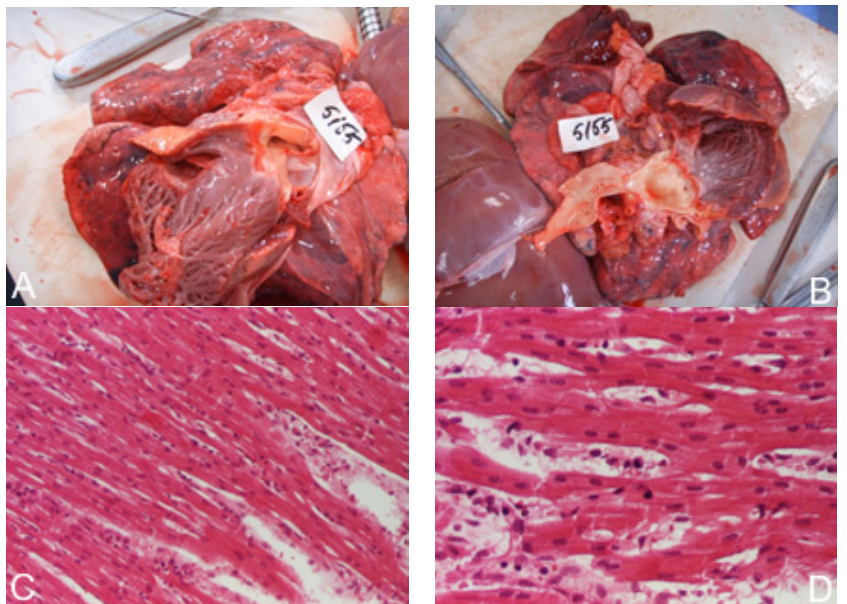
Figure 3. Dilated cardiomyopathy echocardiogram. ( A )—Severe mitral regurgitation (apical four- chamber); ( B )—tricuspid envelope continuous Doppler; ( C )—trans-mitral pattern that is suggestive of atrial fibrillation.